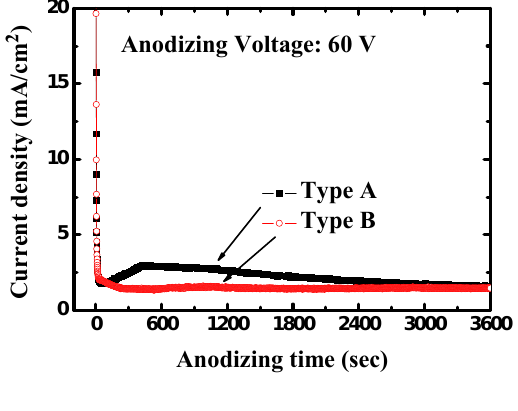
Figure 3. The variation of current density in anodization process for different